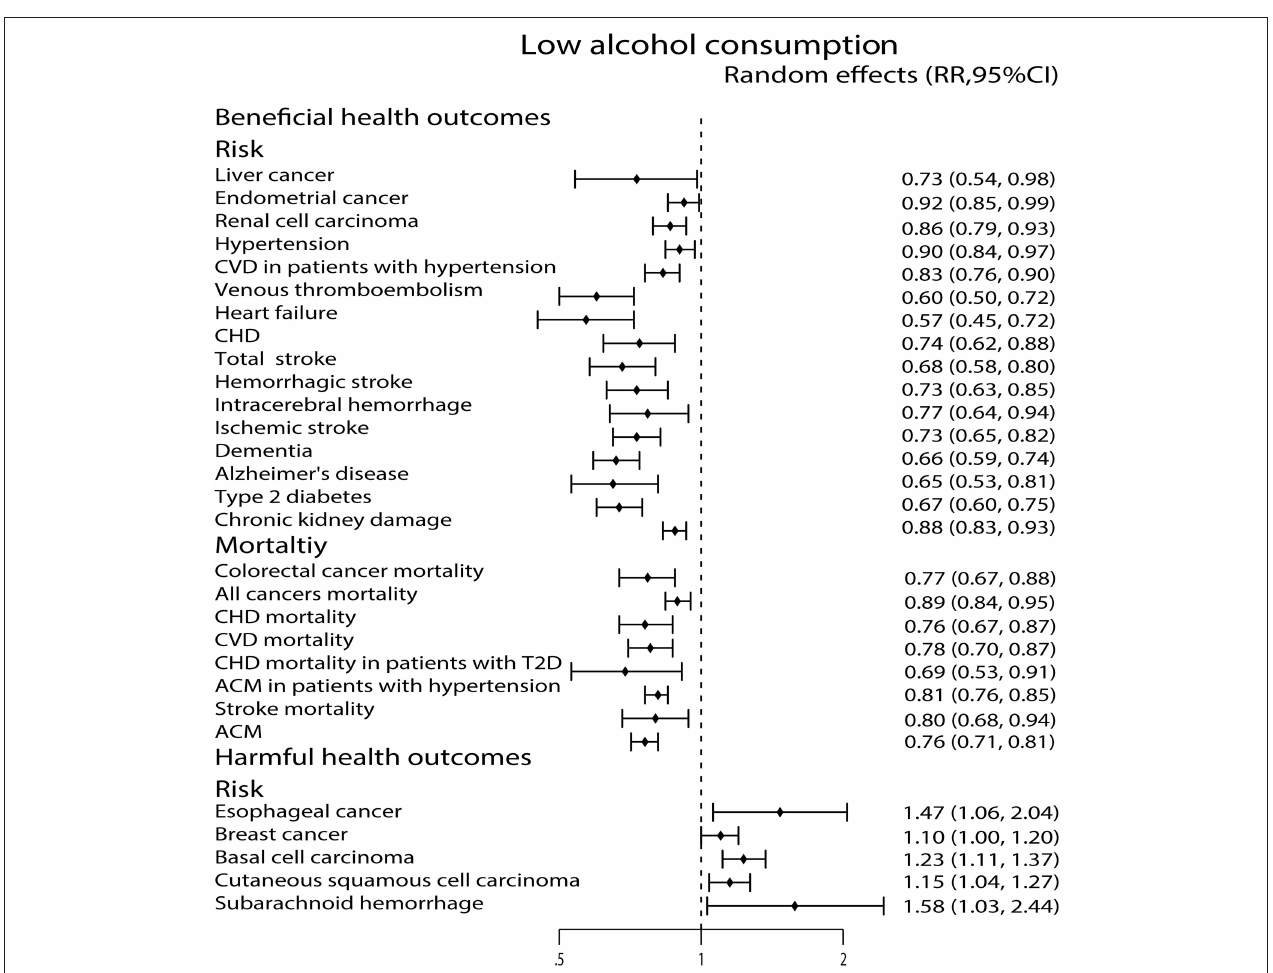
FIGURE 3 | Forest plot: recalculated effects estimates of meta-analyses reporting significant associations of low alcohol consumption with health outcomes. RR, relative risk; CI, confidence interval; CVD, cardiovascular disease; CHD, coronary heart disease; ACM, all-cause mortality.